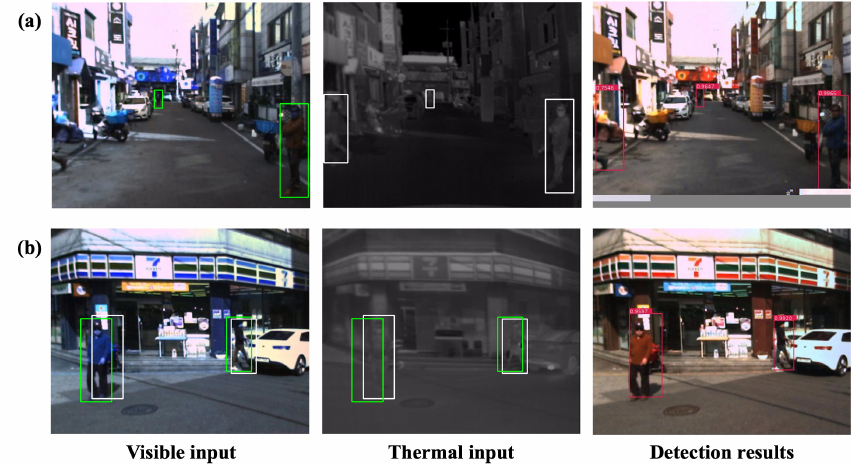
Figure 1. Illustration of inter-modality complementarity and dislocations. ( a ) modality complemen- tarity, where thermal features complement the impairments of visible features. ( b ) Object dislocations, where the misalignment of the two modes causes the quality of the fused features to be impaired. Our HAFNet eliminates the misalignment of objects between visible and thermal modalities and adaptively fuses the corresponding features to boost